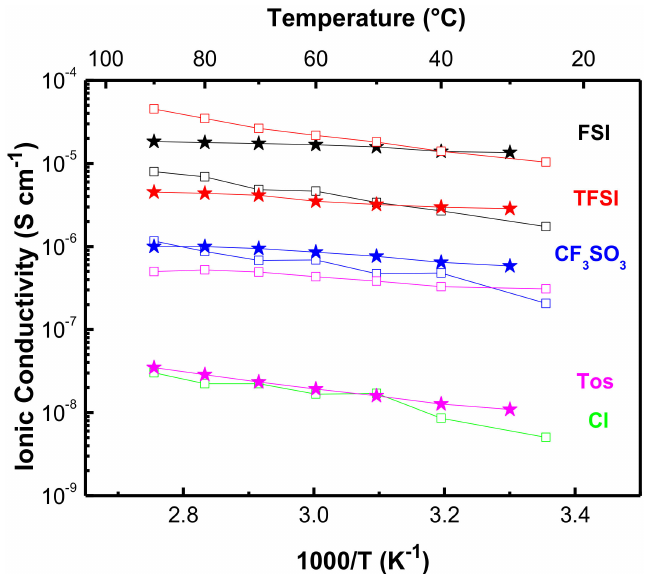
Figure 9. Ionic conductivity values of PEDOT:PolyDADMA X (squares) and 80 / 20 PEDOT:PolyDADMA X / [C 2 mpyr][X] composites (stars), where X is FSI (black), TFSI (red), CF 3 SO 3 (blue), Tos (pink) and Cl (green).